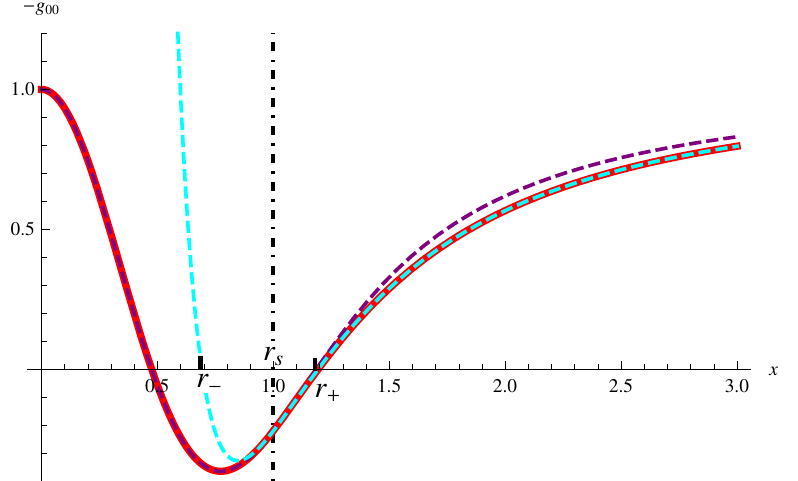
Figure 3. An example of β < β 1 and β < β 2 : n = 5, β = 0.04. This case is characterized by r − < r s < r + and one f ( r ) -horizon.